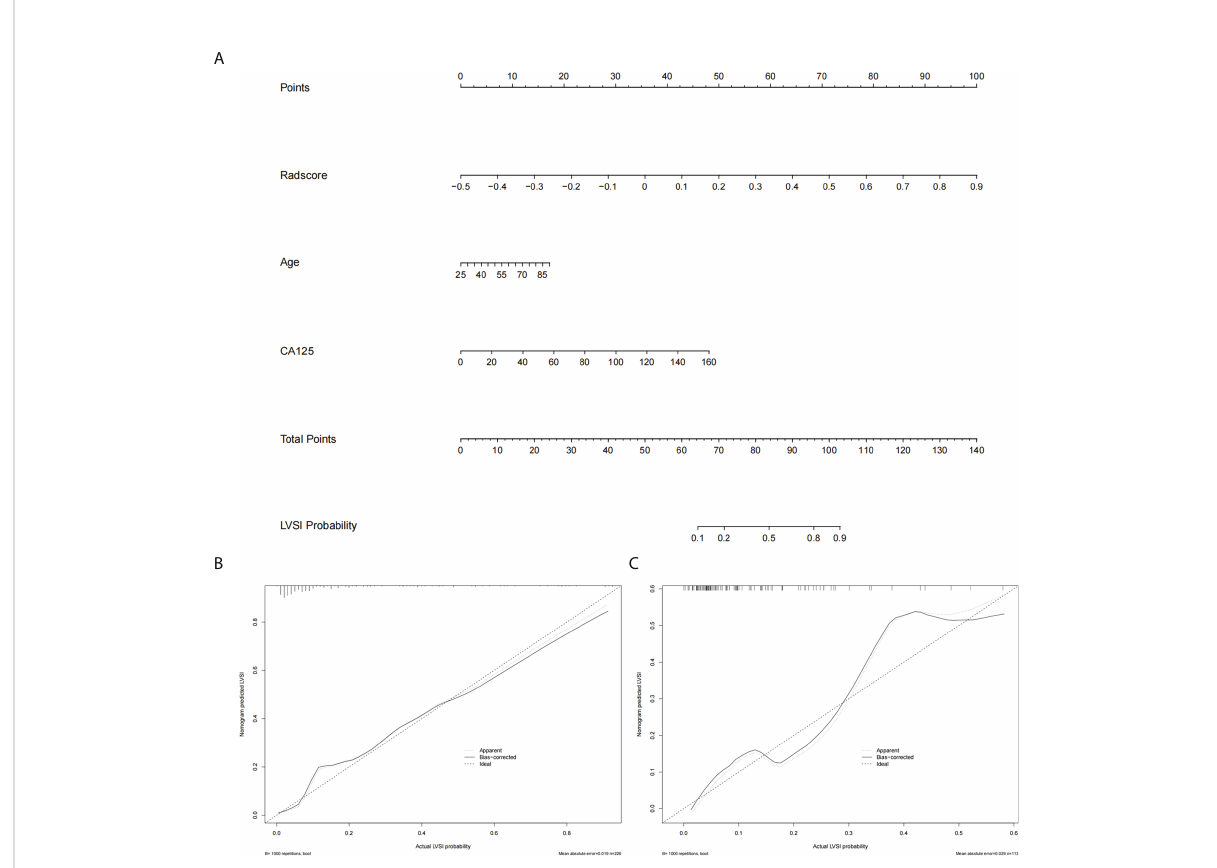
FIGURE 4 The radiomics nomogram and calibration curves. (A) The radiomics nomogram is constructed by integrating radscore with patient age and CA125. The calibration curve of the radiomics nomogram for predicting LVSI in the training group (B) and the test group (C)